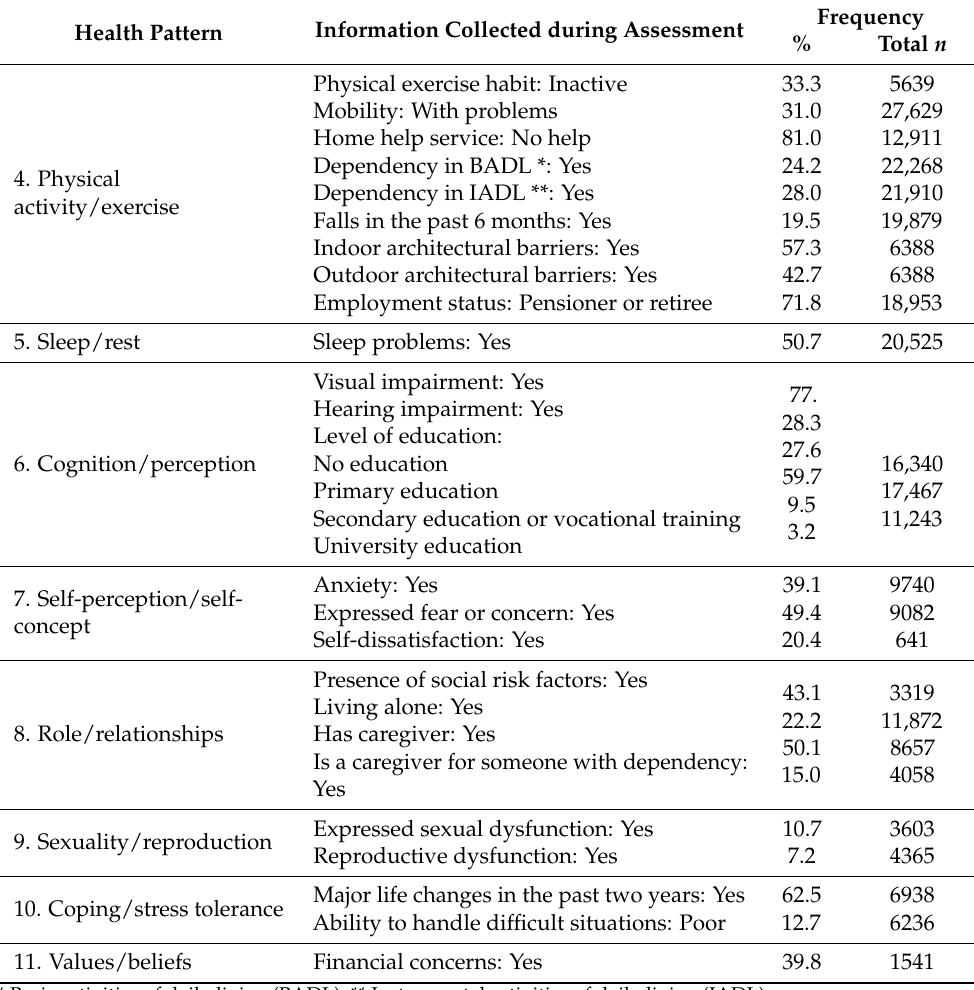
Table 3. Cont. Health